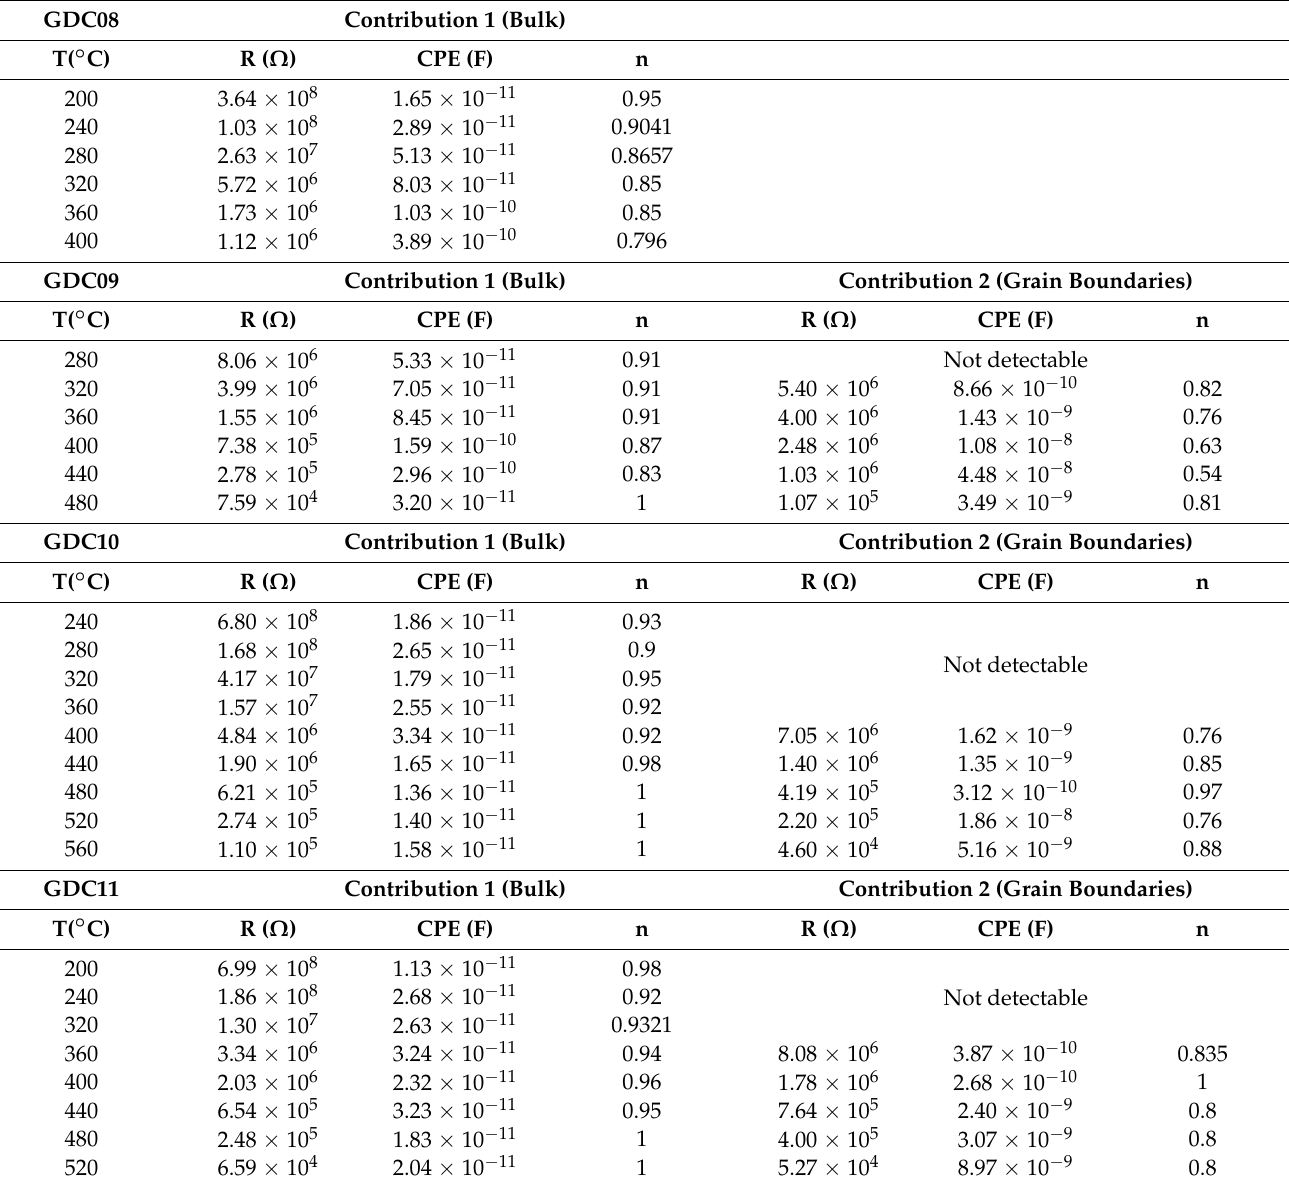
Table 3. Value of the electrolyte fit result for all samples as a function of